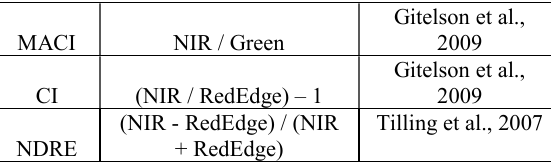
Table 2. Indices and equations for calculation